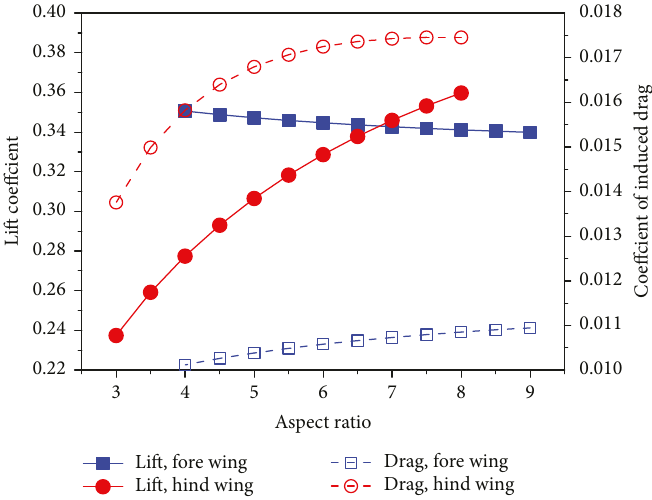
Figure 19: E ff ect of aspect ratio on lift coe ffi cient and induced drag for tandem wing con fi